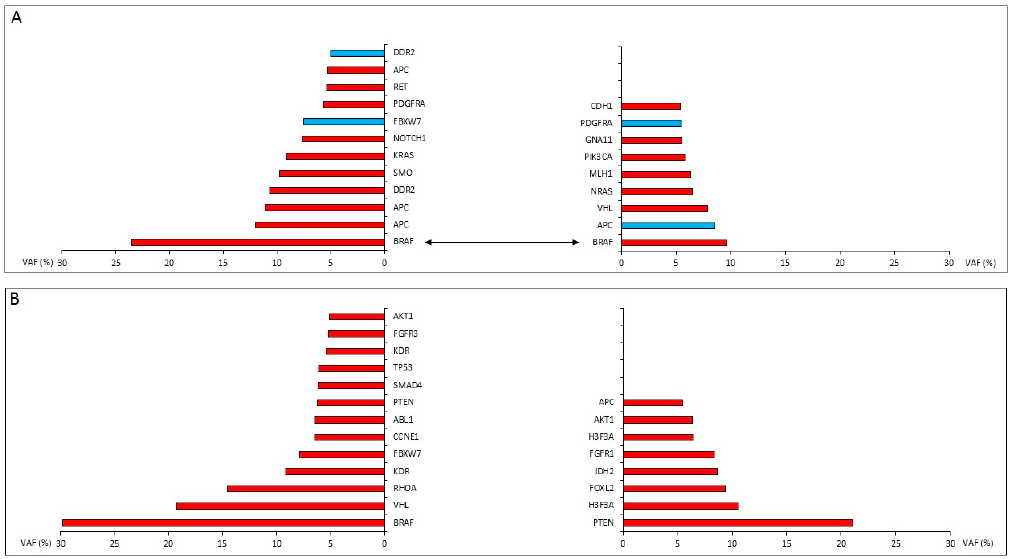
Figure 2. Results of the 67-gene NGS sequencing from two cases with synchronously growing thyroid carcinomas in association with Hashimoto’s thyroiditis. ( A ) Independent synchronous tumors from the same thyroid gland (case 1) shared the classical V600E mutant BRAF genotype but no other variants. ( B ) No single match within the series of 13 and 8 gene variants detected in the two simultaneously growing tumors of case 14. Red bars represent missense variants, and blue bars indicate stop gain. x axis: allele frequency of the gene variant (variant allele frequencies (VAF) %) identified.